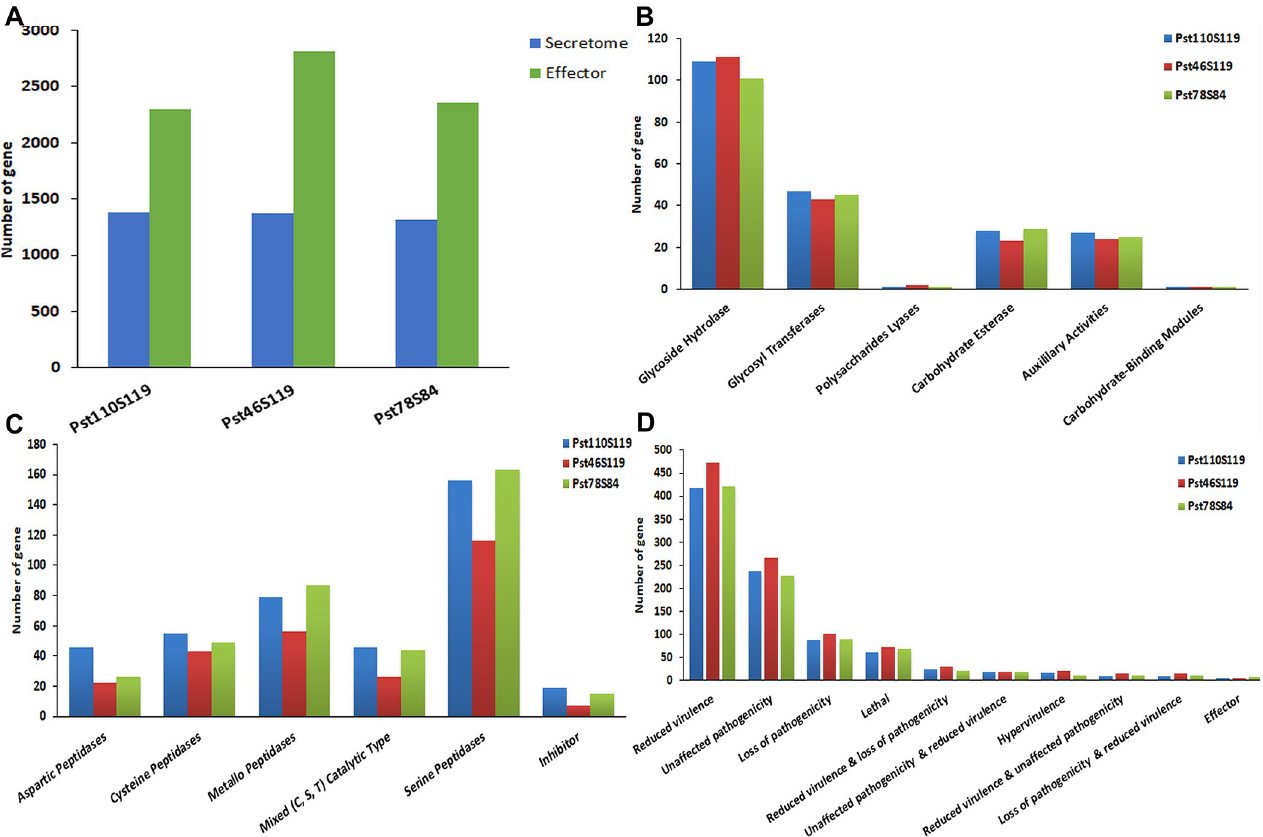
Fig 2. Distribution of pathogenicity gene families A) effector and secretome B) CAZyme classes C) protease classes and D) PHI-base homologs in the three Pst110S119, Pst46S119 and Pst78S84 isolates.